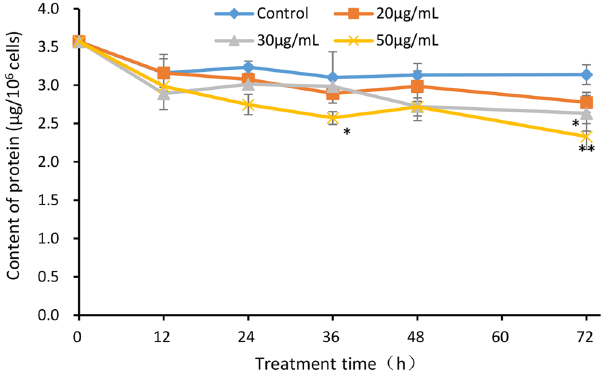
Figure 9. Effect of PG on protein content of M. aeruginosa . Values are means ± SD (n = 3). * ( p < 0.05) and ** ( p < 0.01) represent significant differences compared to the control cells.